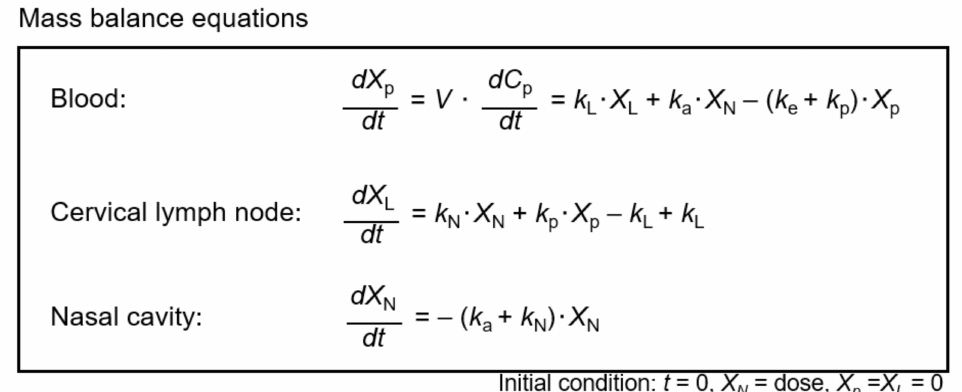
Figure 2. Mass balance equations used for the calculation of pharmacokinetic parameters based on the absorption–disposition model considered for nasal administration. Abbreviations: X , mass of methotrexate in each compartment; k , rate constant; V, volume of distribution; C , concentration of methotrexate; N, nasal cavity; L, cervical lymph node; p, plasma.